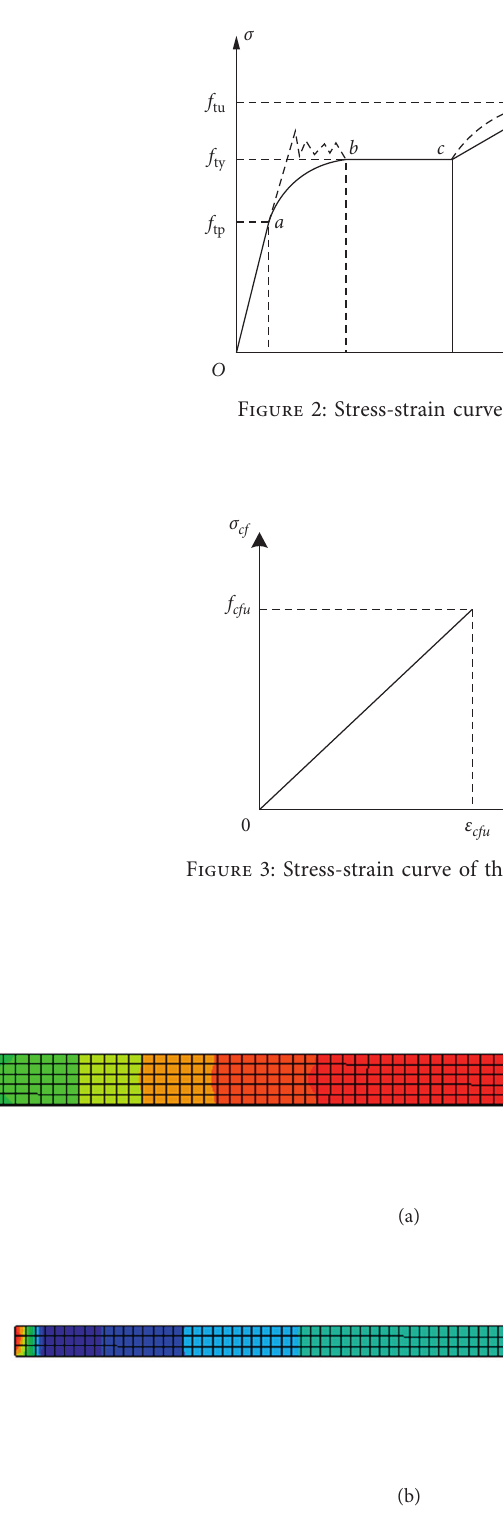
Figure 4: Strain distribution under the temperature of 20 ° C. (a) Bottom flange of the steel beam. (b) CFRP